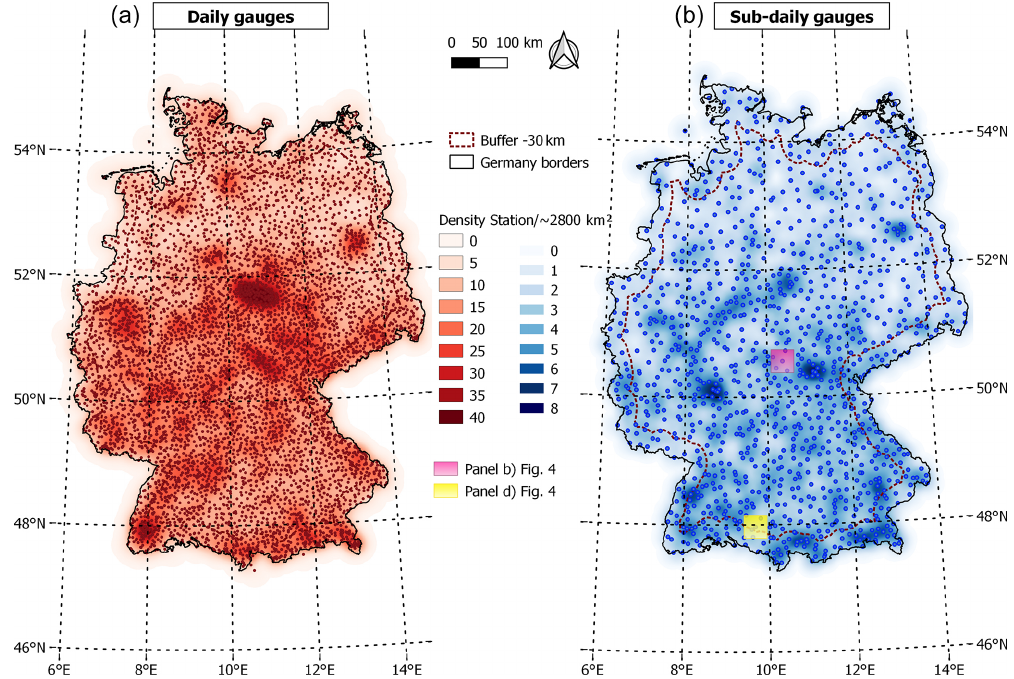
Figure 1. Map of the study area showing the location and density (number of stations per ∼ 2800km 2 ) of the DWD gauges with daily (a) and sub-daily (b) resolutions. The yellow and pink boxes in the map on the right refer to the two locations of the examples presented in Fig. 4. Table 1. Average transformation factor λ used to transform the original data to the truncated normal space with reduced skewness. 60min 120min 180min 240min 720min Average transformation factor